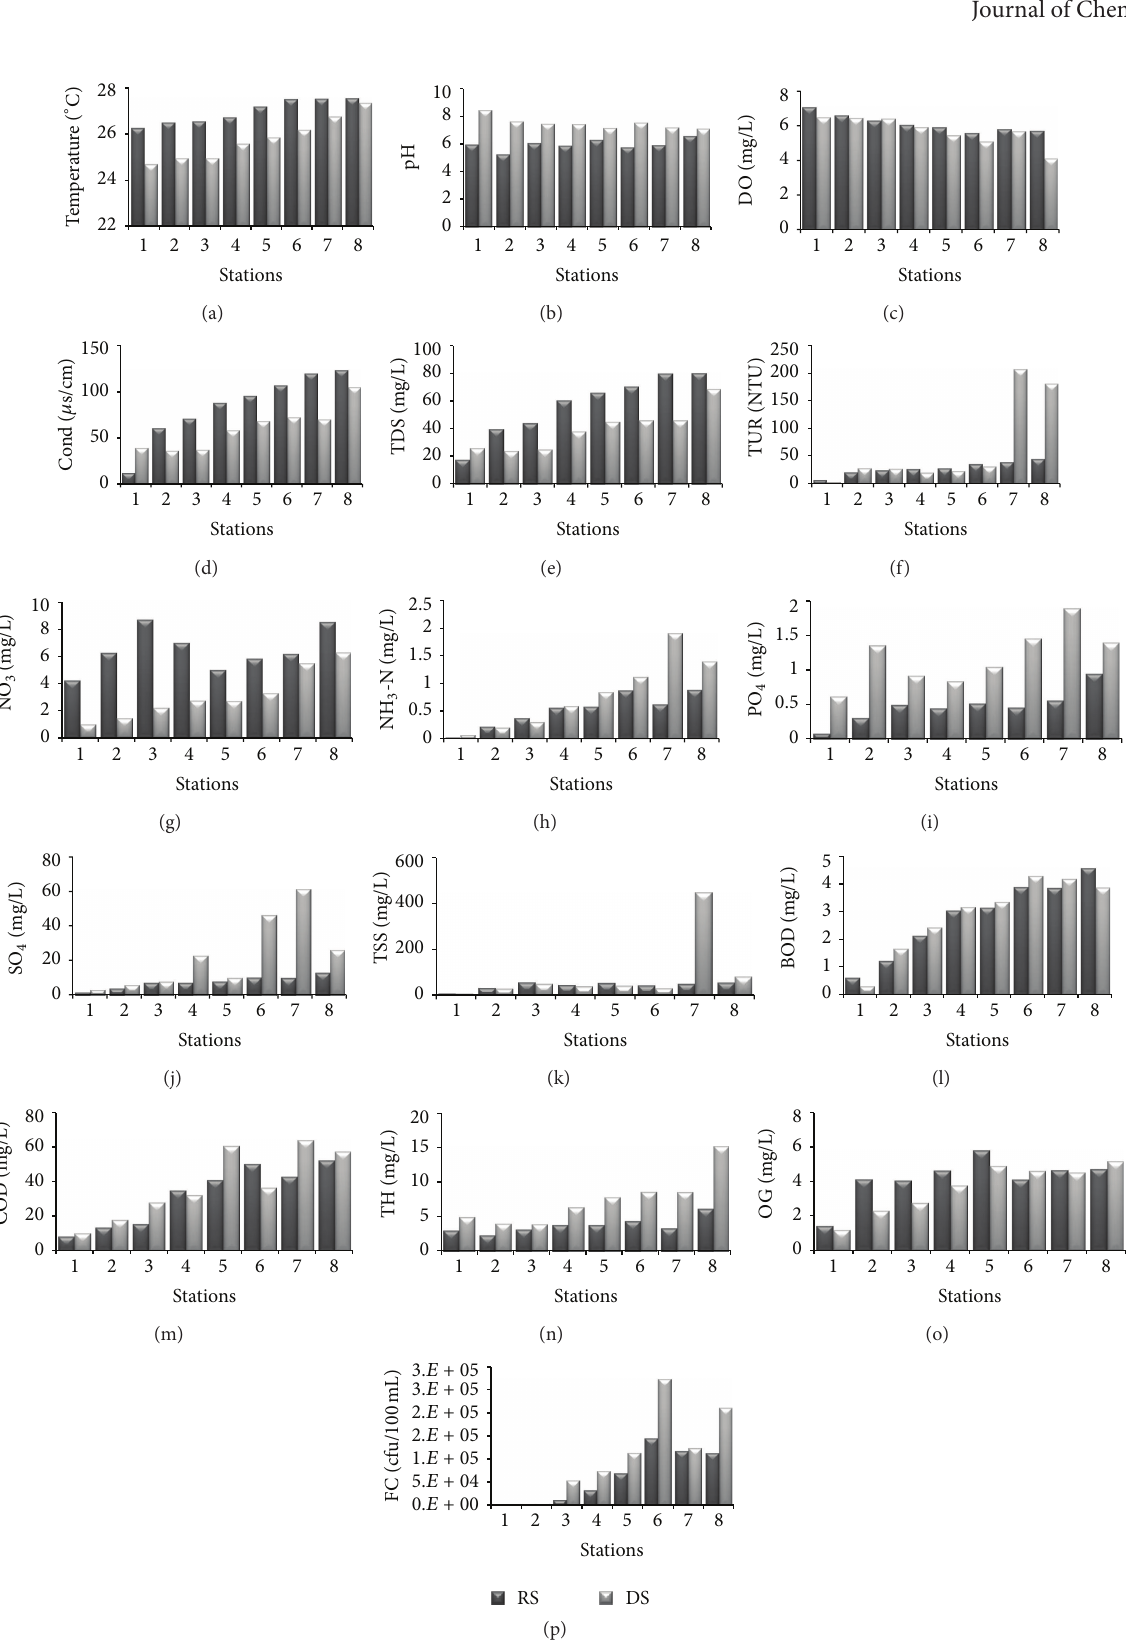
Figure 2: Distribution of values for (a) temperature, (b) pH, (c) DO, (d) conductivity, (e) TDS, (f) turbidity, (g) NO 3 , (h) NH 3 -N, (i) PO 4 , (j) SO 4 , (k) TSS, (l) BOD, (m) COD, (n) TH, (o) OG and, and (p) FC between rainy and dry seasons, Semenyih River, Stations